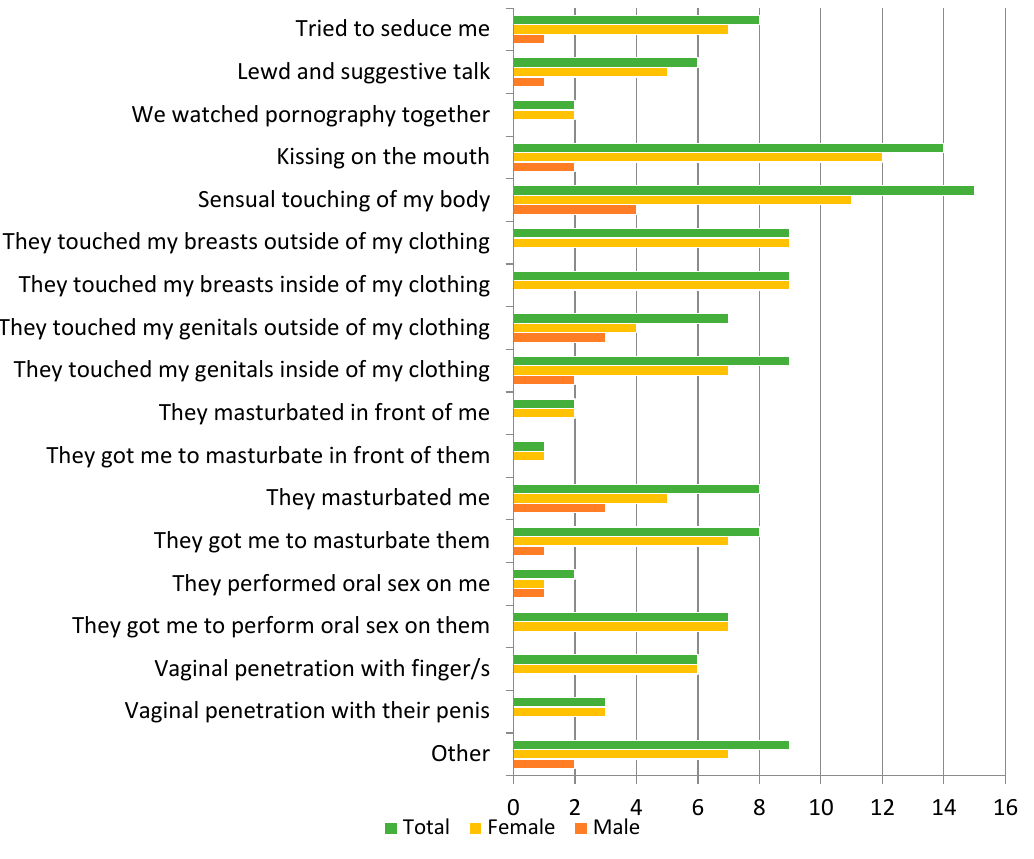
Figure 1. Types of abuse ( n = 23).